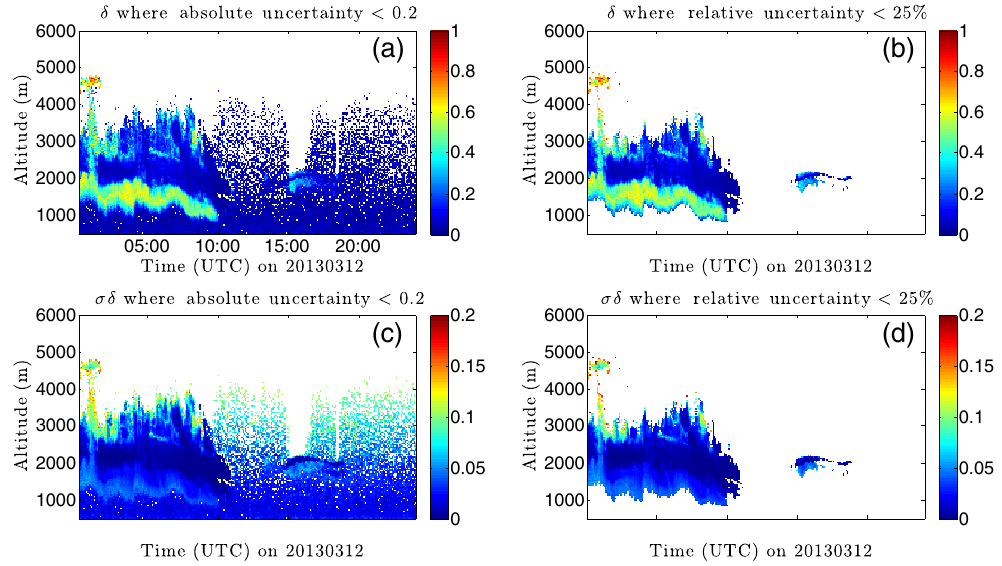
Figure 5. Atmospheric depolarization ratio measurements ( δ ) from 12 March 2013, with associated absolute uncertainties ( σδ ) in units of depolarization ratio. In the left panels of δ (a) and σδ (c) , all data points with absolute uncertainty greater than 0.2 have been eliminated. In the right panels of δ (b) and σδ (d) , points with relative uncertainty greater than 25% have been eliminated instead. Resolution is 5min ×